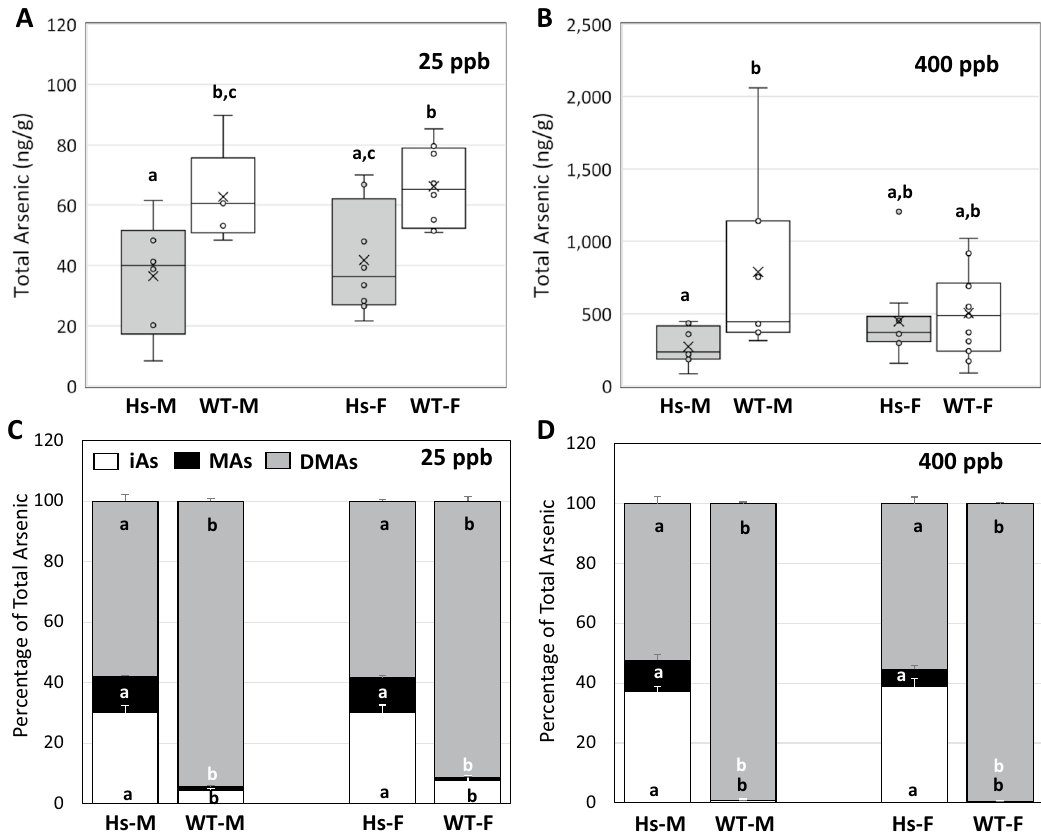
Figure 1. Total arsenic concentrations ( A , B ) and proportions of arsenic species ( C , D ) in urine of humanized (Hs) and wild-type (WT) male (M) and female (F) mice after 4-week exposure to 25-ppb ( A , C ) or 400-ppb ( B , D ) of inorganic arsenic in drinking water. For total arsenic concentrations ( A , B ), mean (×), median (—), 25th and 75th percentiles (box), maximum and minimum (whiskers), and individual values including outliers are shown. For the proportions of arsenic species ( C , D ), each bar and whisker represent mean and standard error of the mean (SEM) value, respectively. For 25-ppb exposure, N = 6 for Hs males and WT males, and N = 8 for Hs females and WT females. For 400-ppb exposure, N = 7 and 8 for Hs males and WT males, respectively, and N = 10 and 11 for Hs females and WT females, respectively. In panels ( A , B ), values marked with different letters are significantly different (p < 0.05). In panels ( C , D ), for each arsenic species, values marked with different letters are significantly different (p <